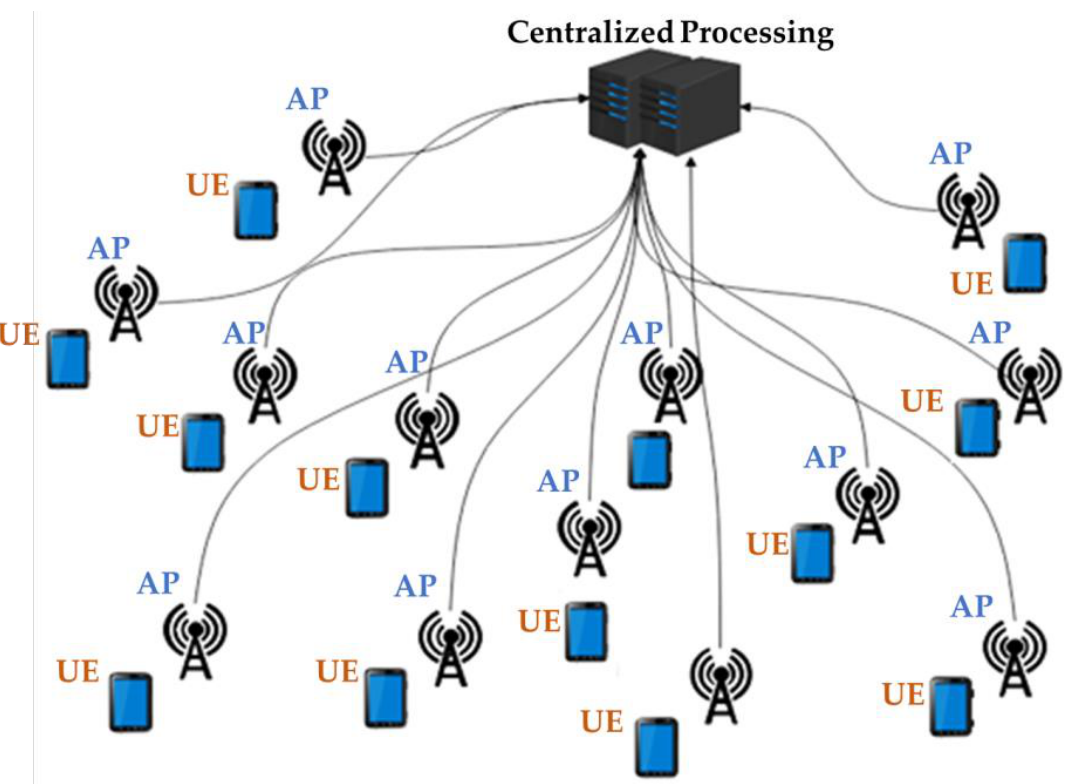
Figure 6. The CF mMIMO architectural system .